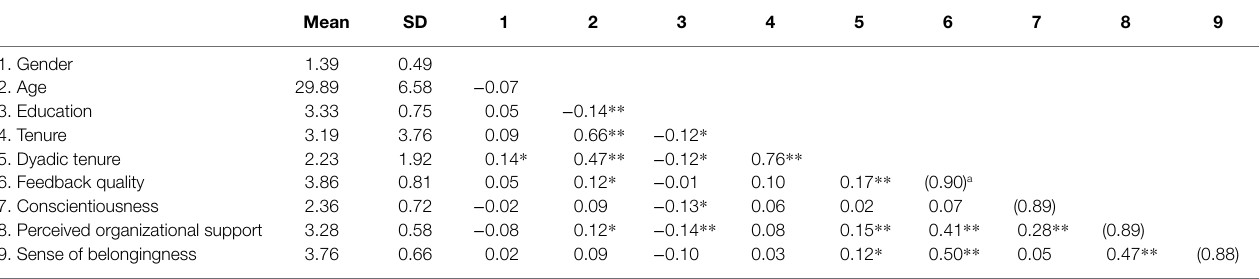
N = 329; Gender was coded “1” for men and “2” for women. Education was coded “1” for “high school diploma or below,” “2” for “college diploma,” “3” for “bachelor’s degree,” “4” for “master’s degree,” and “5” for “doctoral degree.” a Reliability coefficients are reported along the diagonal. * p < 0.05, ** p < 0.01.